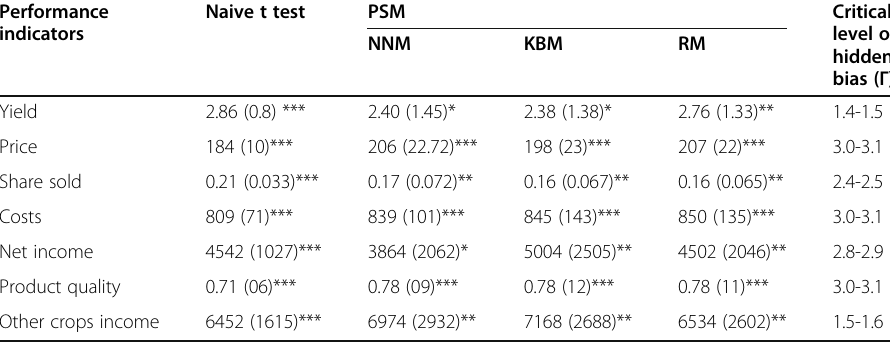
Table 4 Average treatment effects using PSM Performance